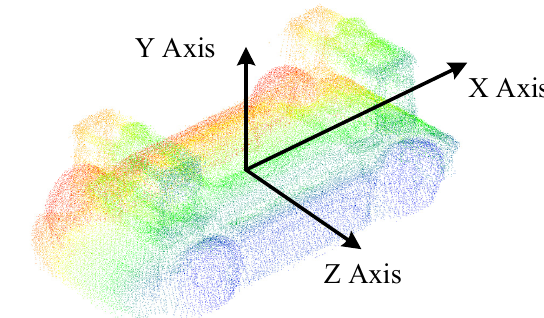
Figure 15. The functional vehicle point cloud template aligned with the origin of the global coordi- nate system.